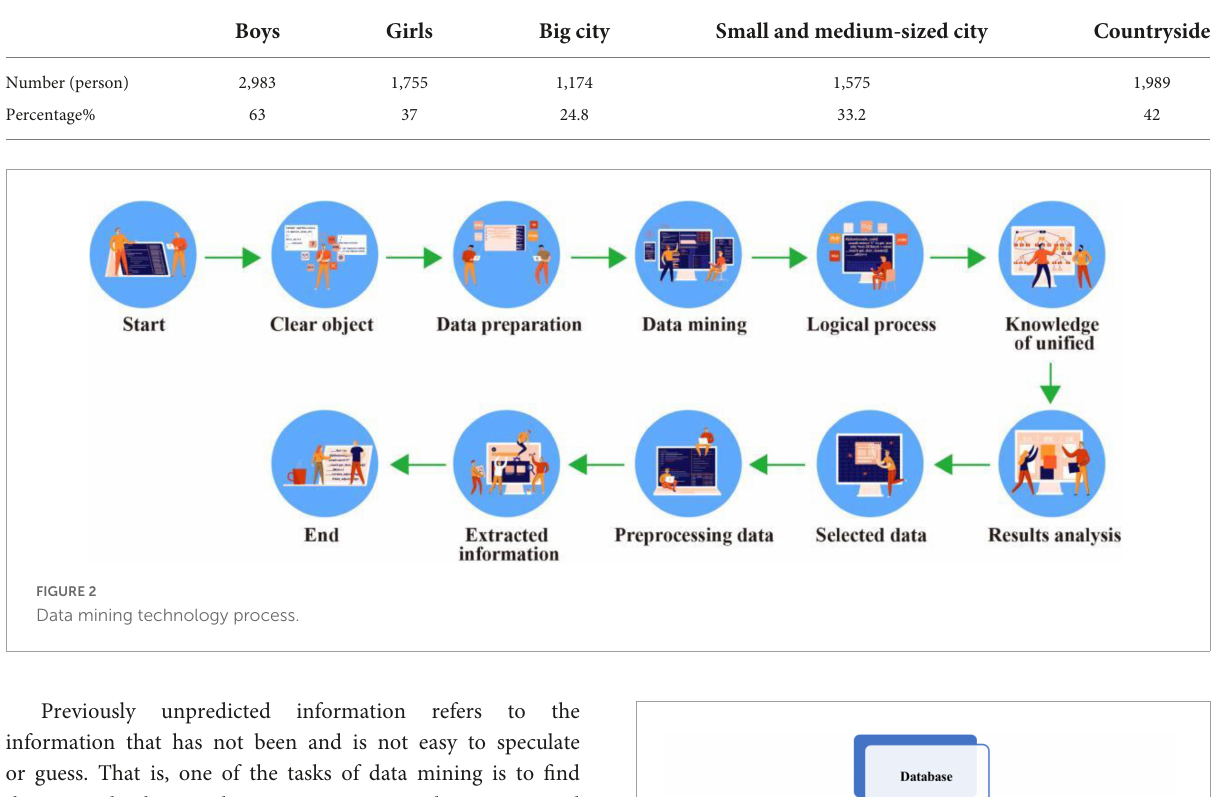
TABLE 1 Statistics of surveyed students.